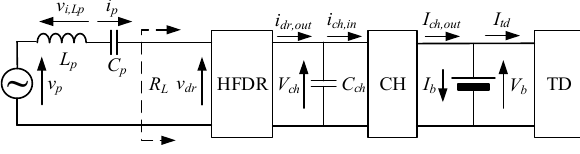
Figure 5. Pickup side conversion stage schematic.